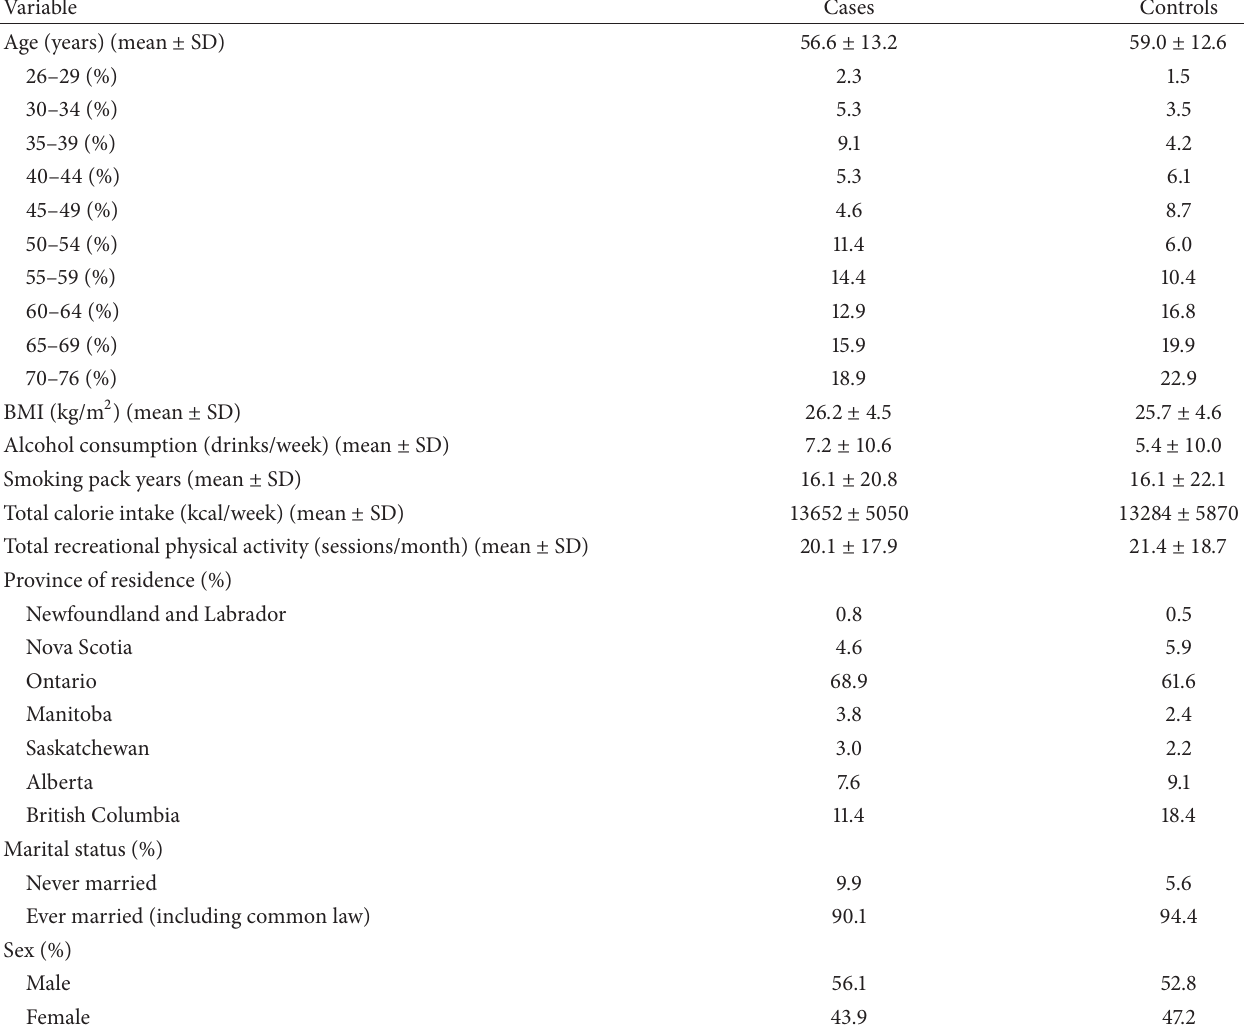
Table 1: Characteristics of cases for salivary gland cancer and controls, Canada,